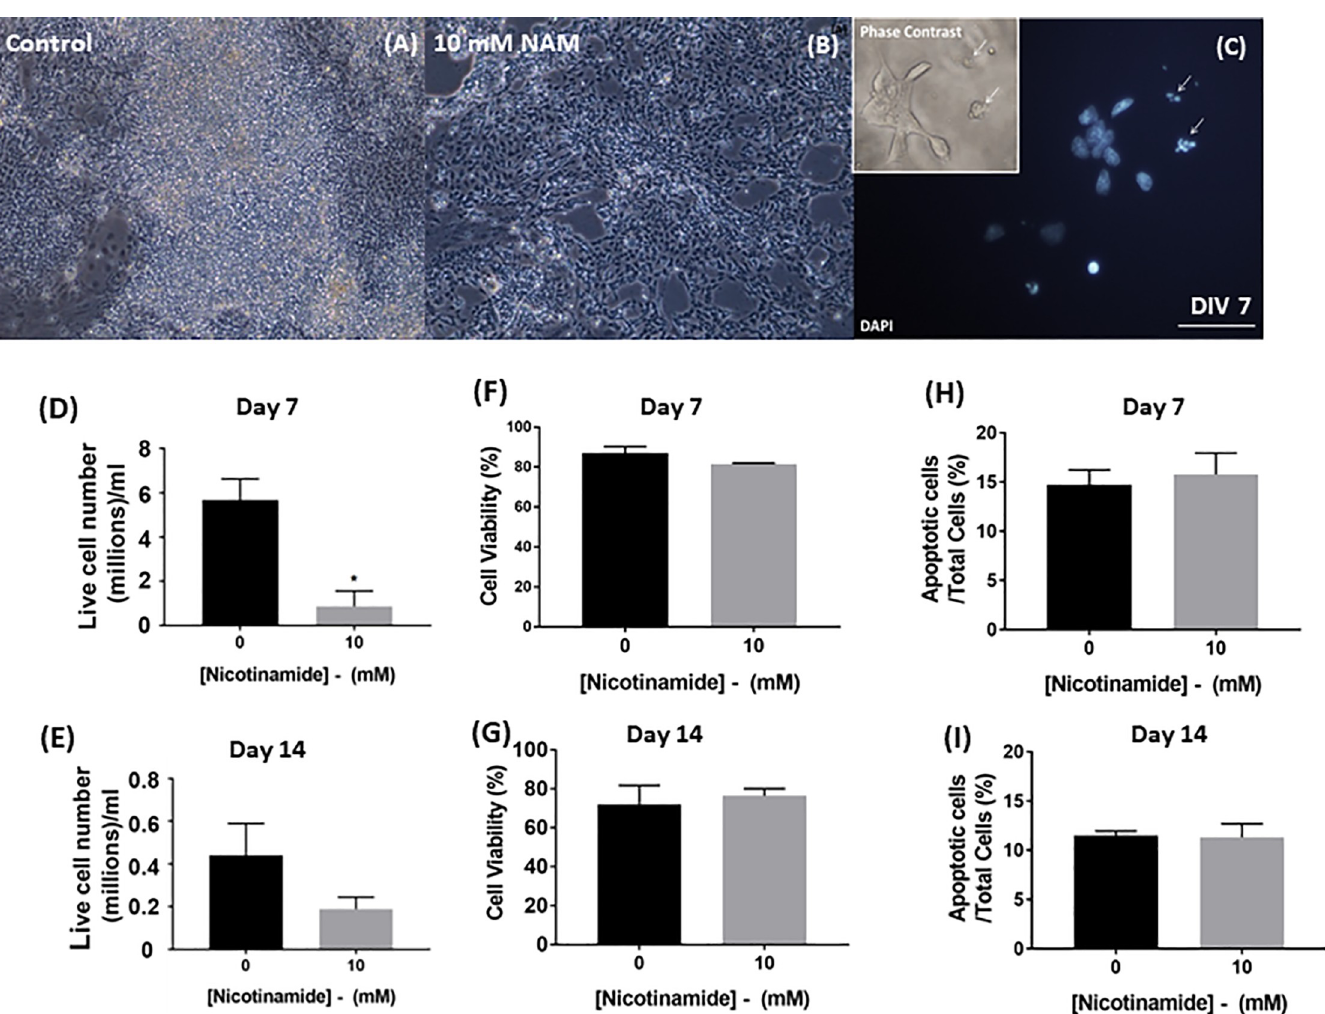
Fig 3. Nicotinamide does not induce apoptosis or alter cell viability in monolayer cultures. Monolayer cultures were exposed to nicotinamide between days 0 and 7, and viability assessed in terms of both total and percentage viable cells at days 7 and 14 of differentiation (A-G). Nicotinamide did not elicit any significant differences in the percentage of viable cells remaining in the cultures at days 7 and 14 (D-E). Nicotinamide administered during the first 7 days of differentiation induced a reduction in live cell numbers at 14 DIV, without evidence of toxicity (F-G). The percentages of apoptotic cell populations were not significantly altered by early nicotinamide treatment in adherent monolayer cultures on days 7 and 14, respectively. Scale bars = 50 μ m. � p <